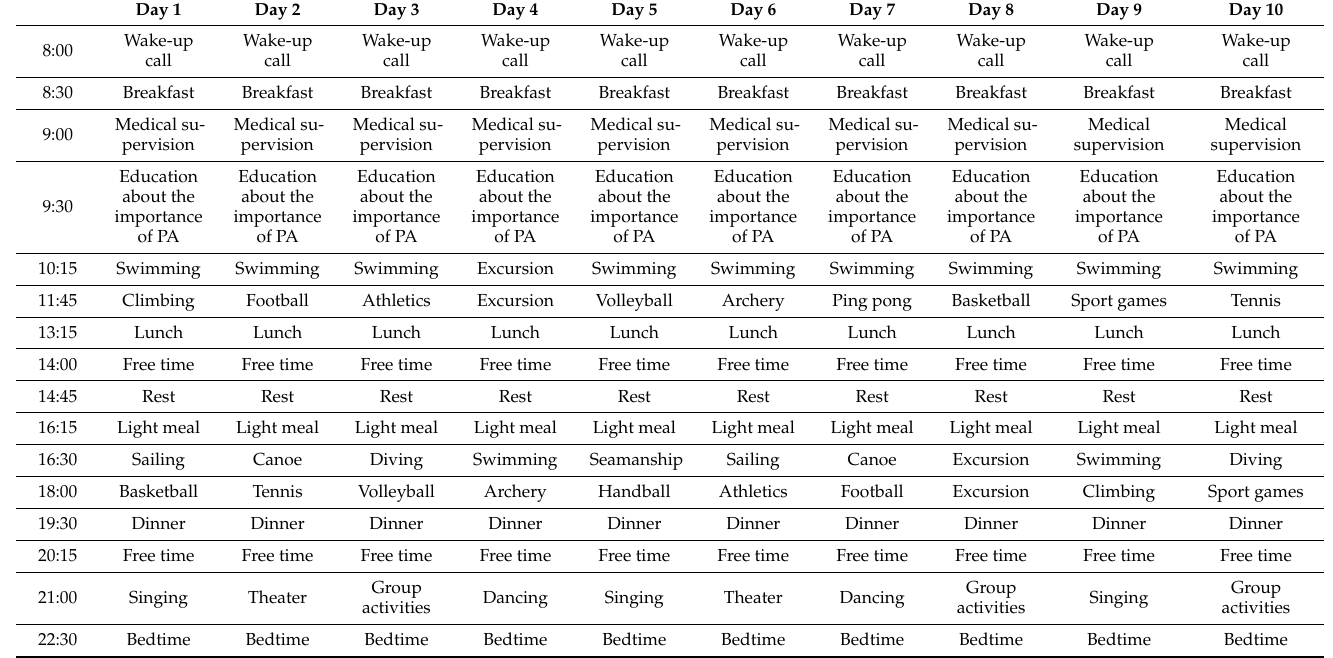
Table 1. Description of the intervention.